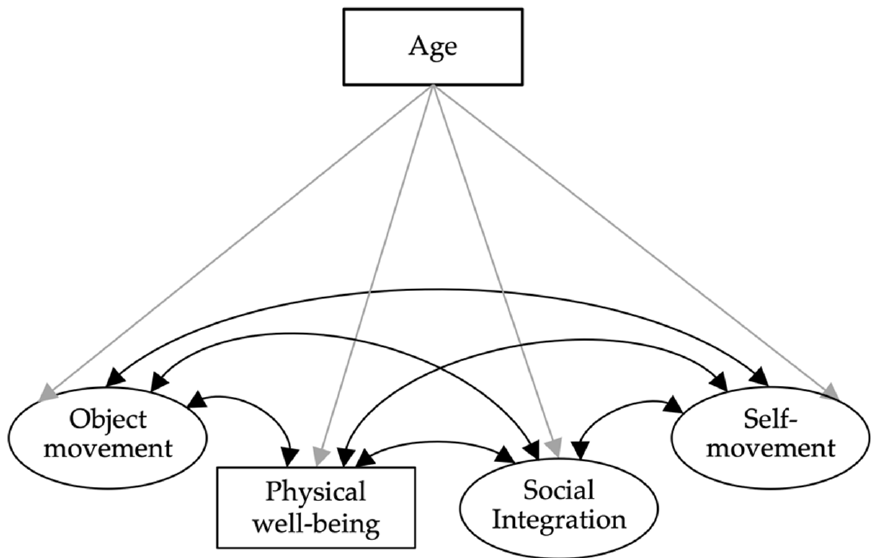
Figure 2. Model 3. Structural equation model showing object movement, self-movement, physical well-being, and social integration with the covariate age.